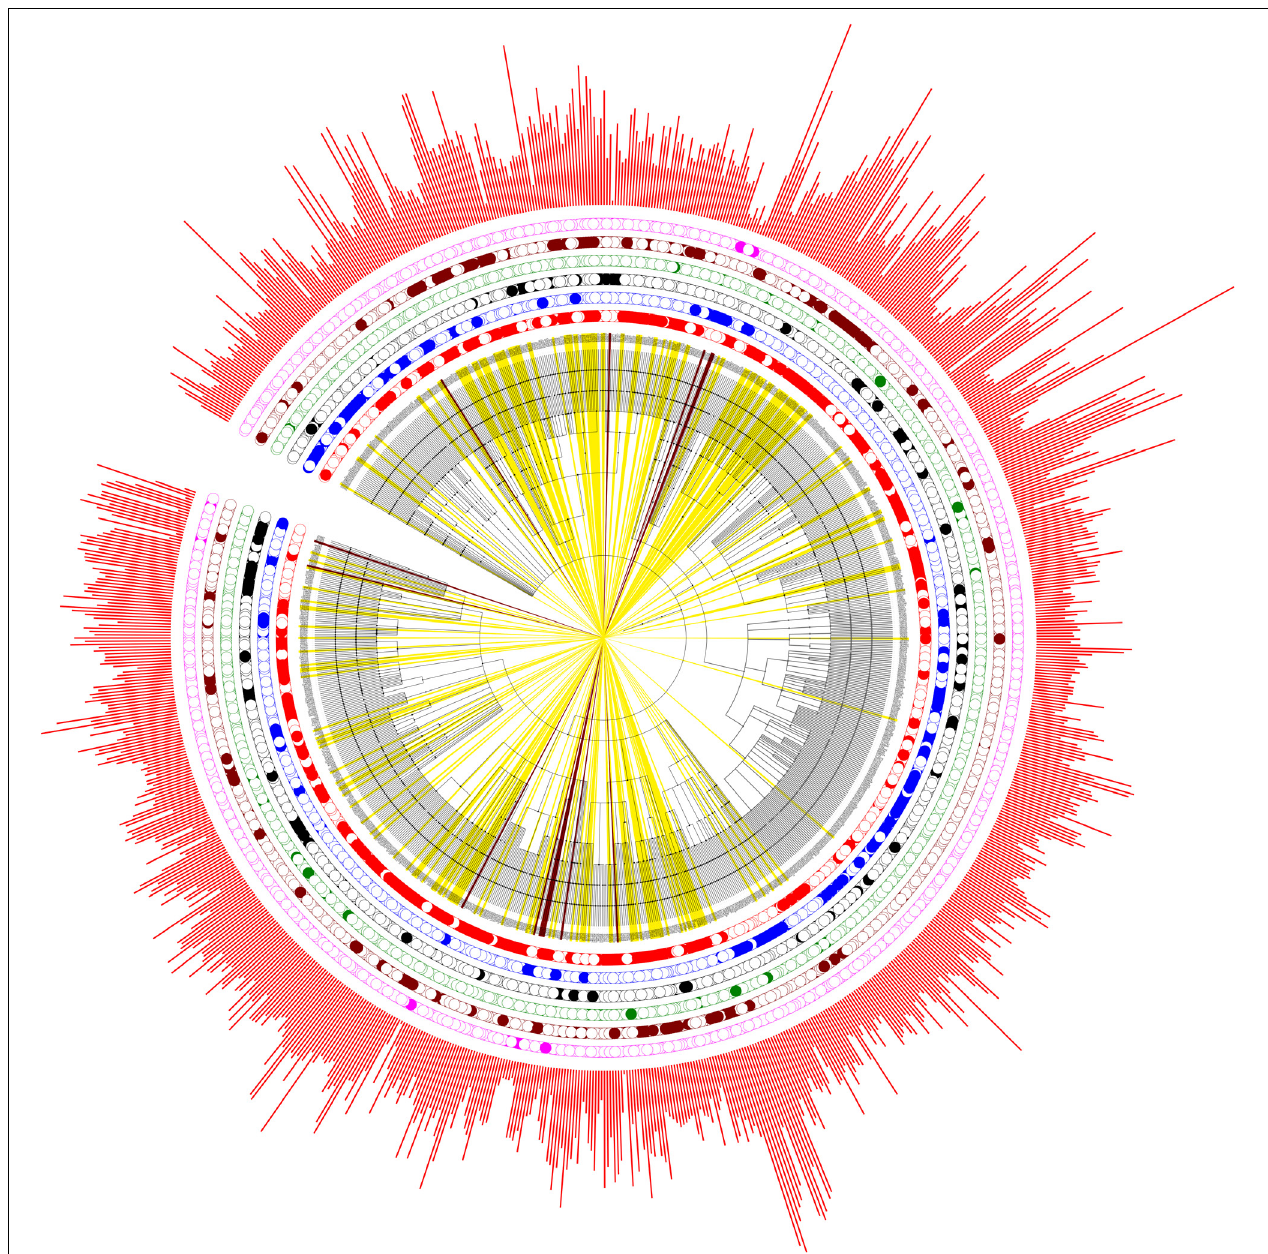
FIGURE 4 | Phylogenetic analysis of the six artificially divided bacterial groups based on gain or loss of polyP-related enzymes. PPK1_2 (red dots), No_PPK1_2 (blue dots), PPK1 (black dots), PPK2 (green dots), Full_Path (brown dots), and No_Path (pink dots). If a bacterium fall into any one of the groups, a dot is marked at the corresponding circled layer. The outmost layer represents bacterial proteome sizes (red bars). In addition, bacteria in Full_Path group are marked by yellow strips while those belonging to No_Path group are colored by dark brown